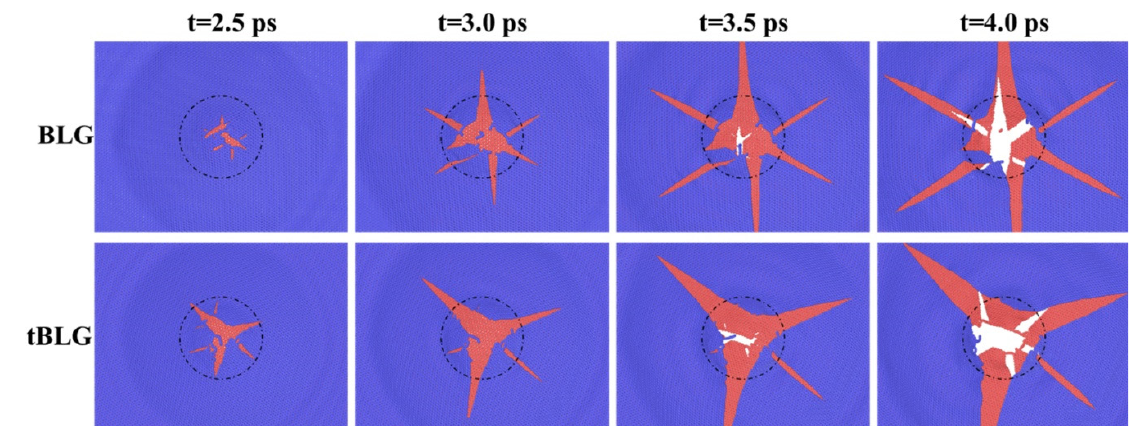
Figure 3. Crack-orifice patterns of BLG and tBLG evolving with time in penetrated cases. The dashed circle outlines the diamond projectile impact region. The top (first) graphene layer carbon atoms are blue. The bottom (second) graphene layer carbon atoms are red. The white color represents the broken region where both top and bottom layers of graphene are removed so that there are no carbon atoms. Some small, isolated objects are debris of carbon atoms of the top (blue) or bottom (red) graphene layer.